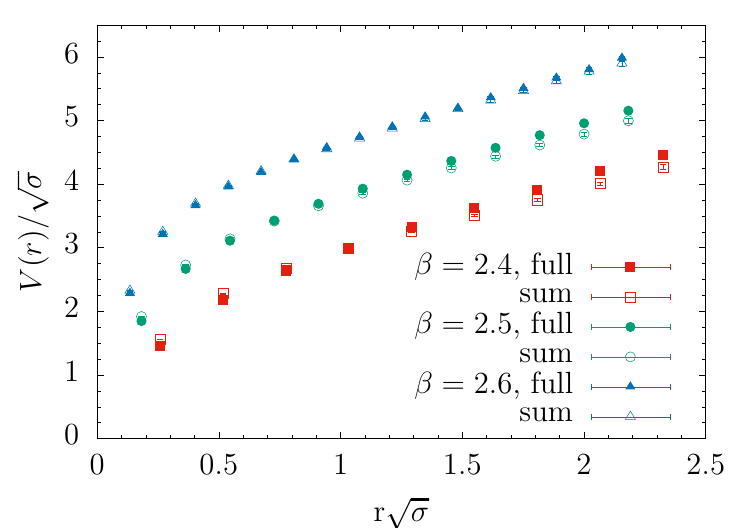
Figure 1. Comparison of the nonabelian static potential V ( r ) (filled symbols) with the sum V mon ( r ) + V mod ( r ) (empty symbols) for Wilson action at β = 2 . 4 (squares), β = 2 . 5 (circles), β = 2 . 6